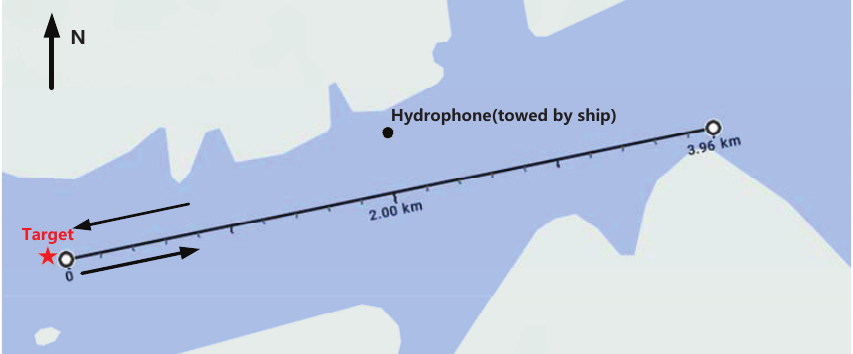
Figure 8. Environment and settings for lake trial, see the text for